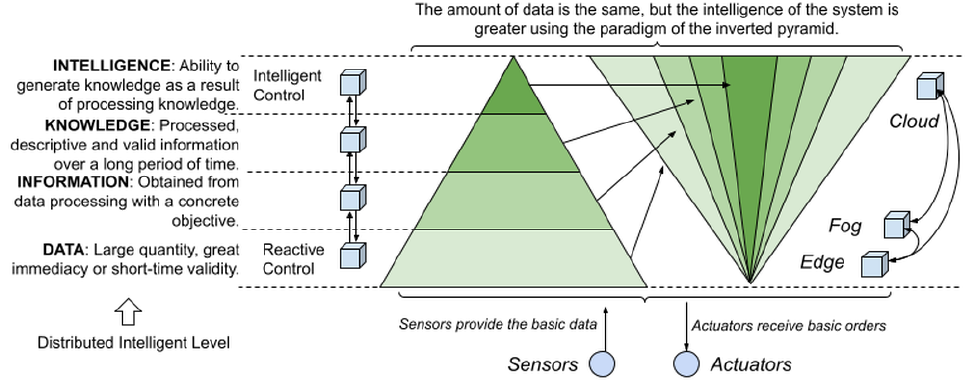
Figure 1. The different intelligence levels are related to the classic vision of the pyramid of knowledge (left side of the figure) and the relationship with intelligent control (right side of the